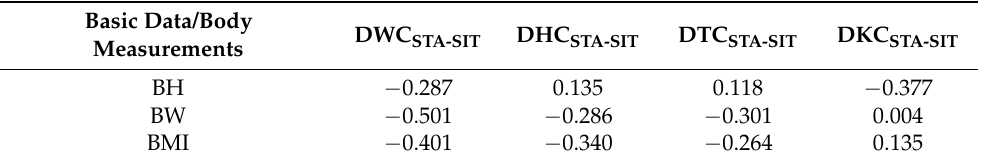
Table 7. Pearson correlation coefficients between the basic data of the participants and differences of body measurements between the standing and sitting